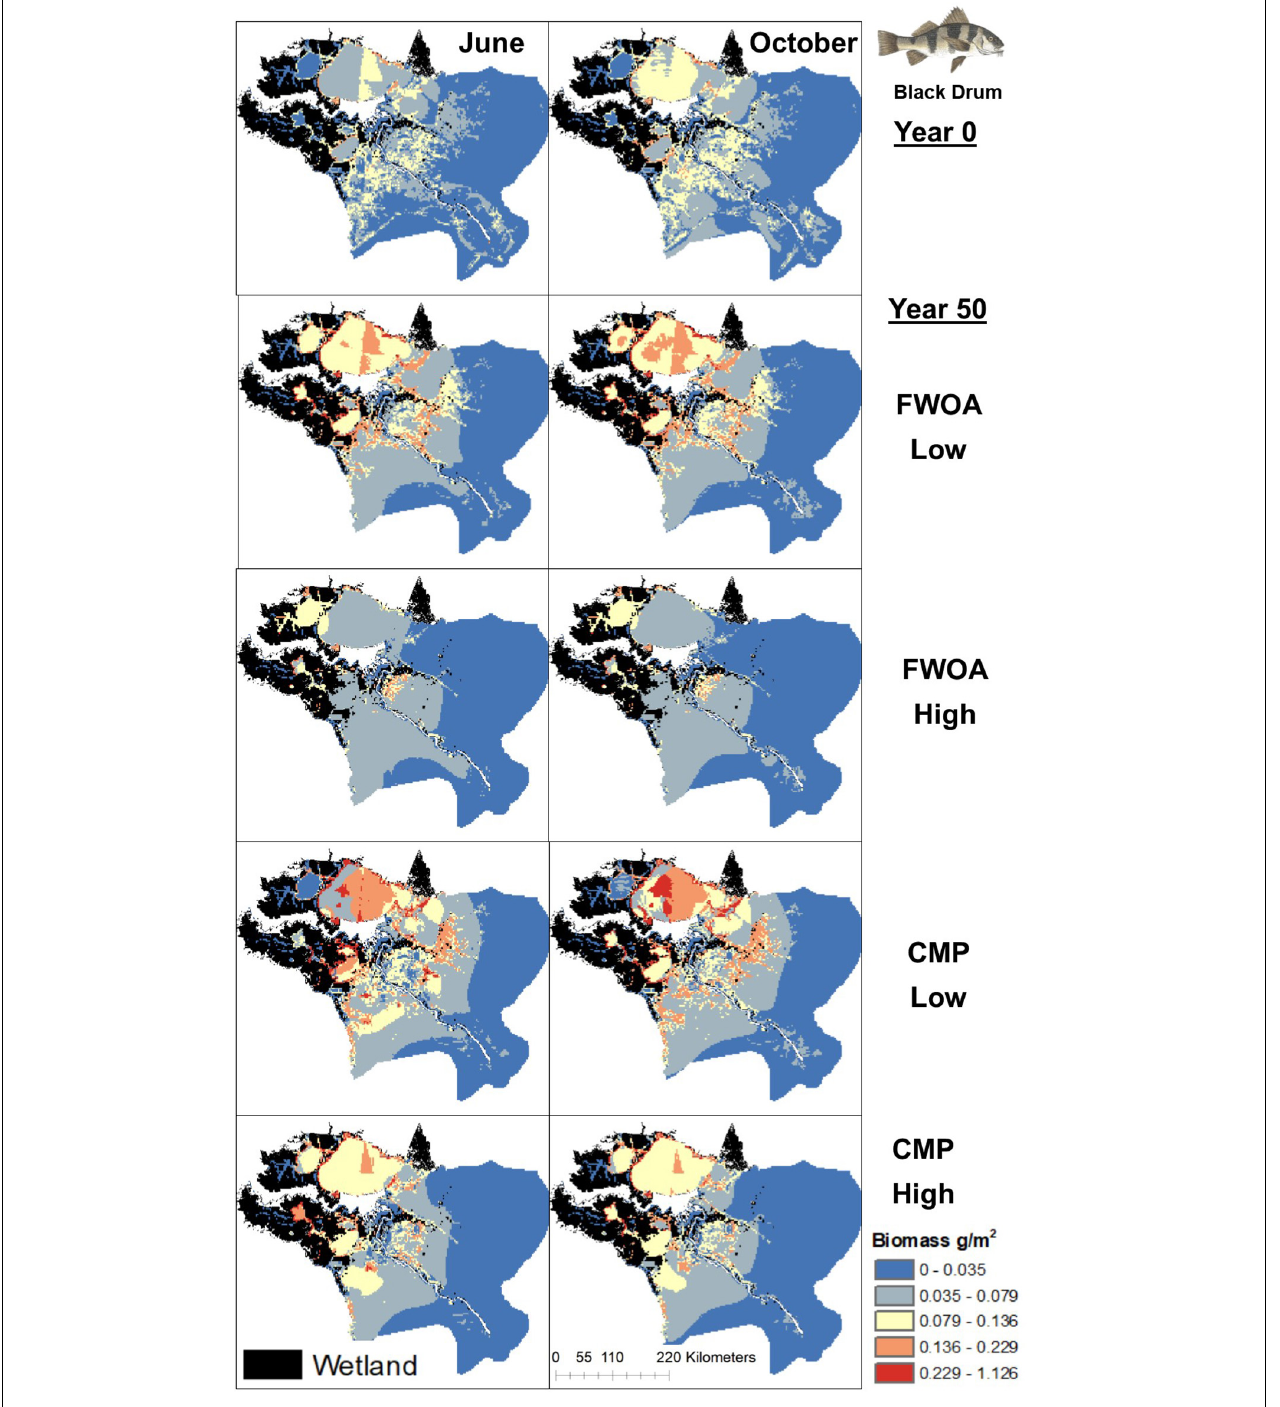
FIGURE 7 | Spatial distribution of juvenile Black Drum in different simulations. Output is shown from June and October in Year 0 and Year 50, under “Low” and “High” relative sea level rise (see Supplementary Table S6 for scenarios), and with Coastal Master Plan (CMP) implementation and without (FWOA).